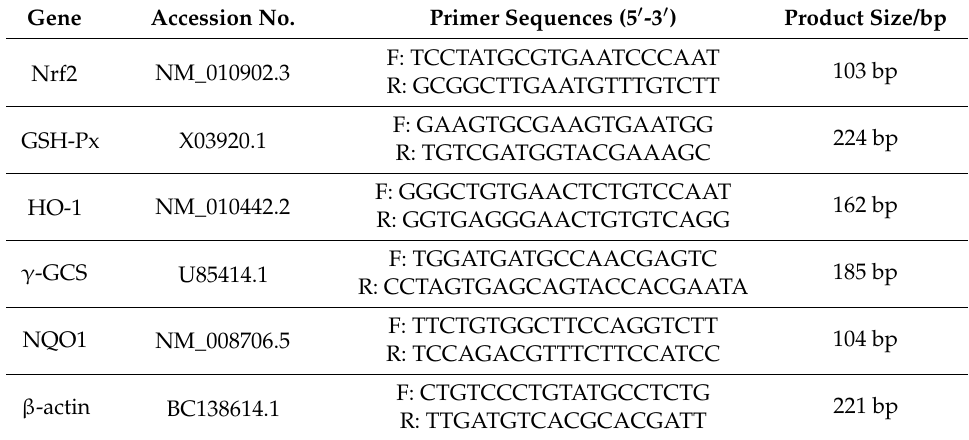
Table 3. Primers for real-time PCR